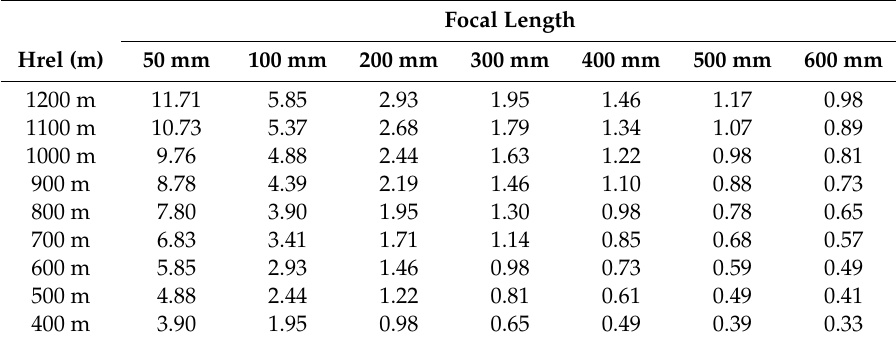
Table 1. Spatial resolution (cm / pixel) as a function of relative flight altitude and focal length. Hrel: altitude above ground.